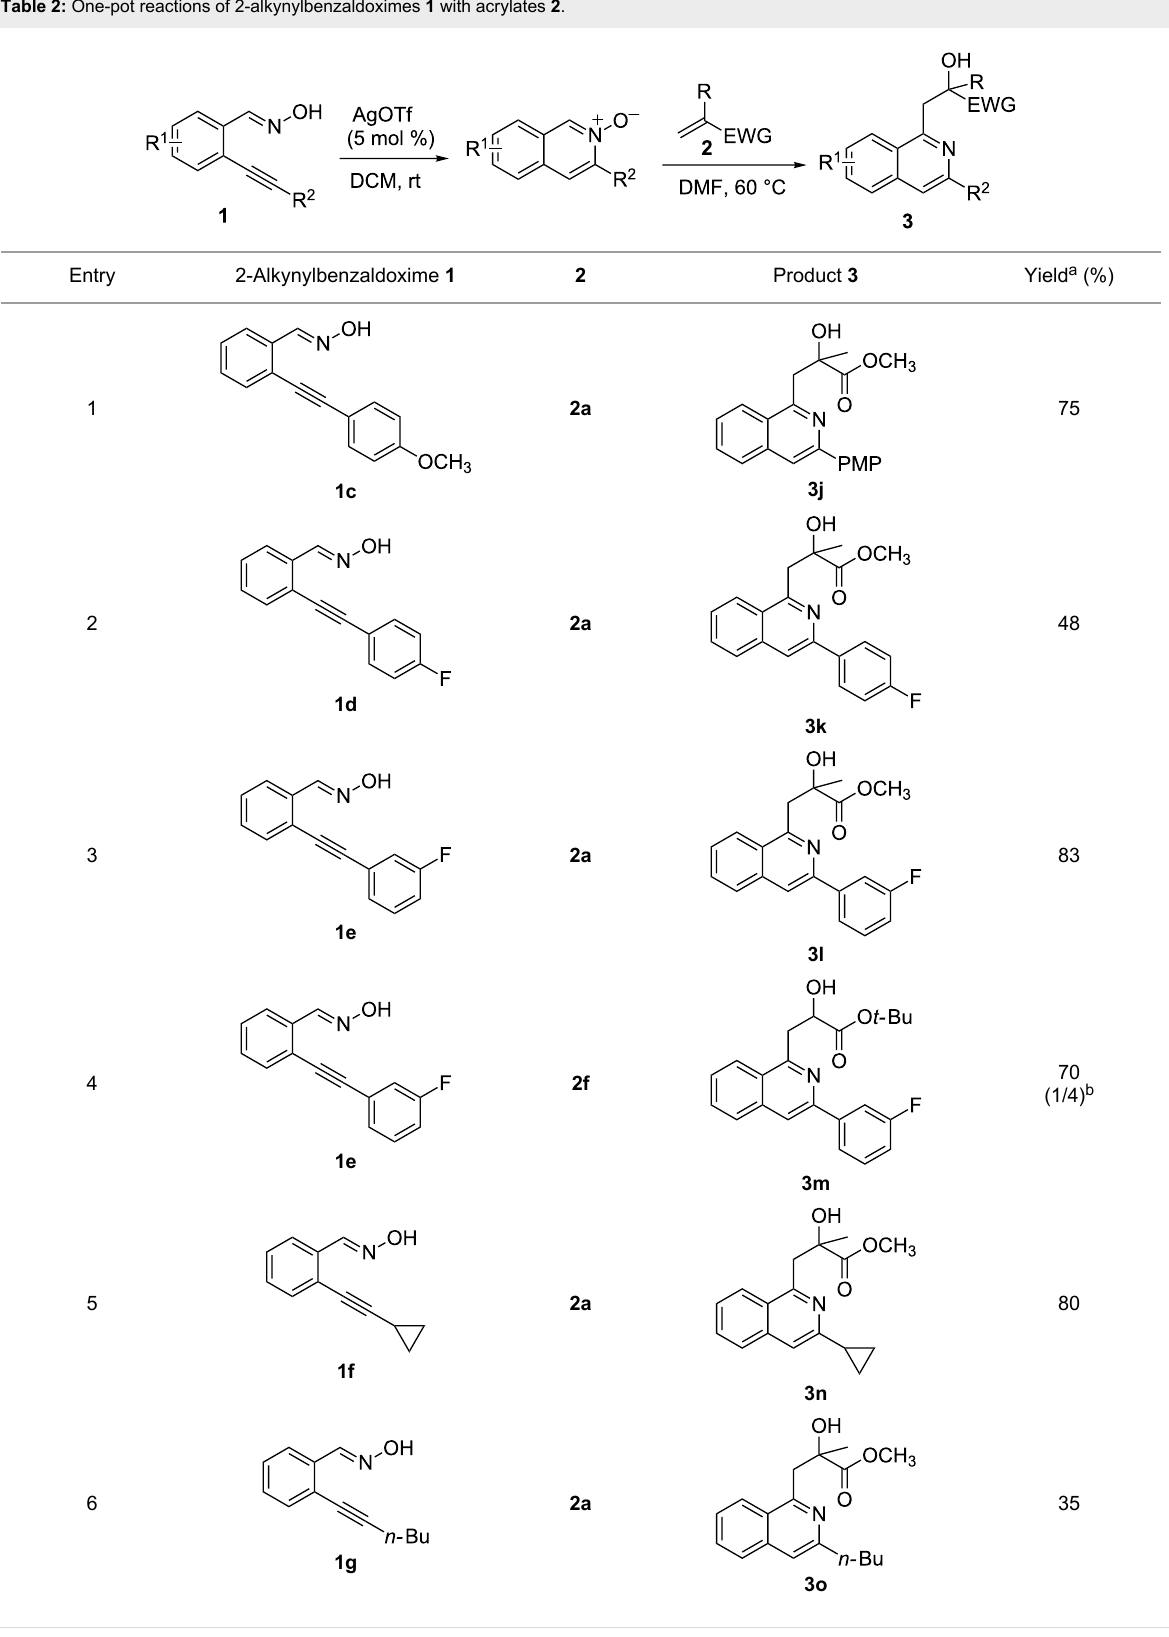
Table 2: One-pot reactions of 2-alkynylbenzaldoximes 1 with acrylates 2